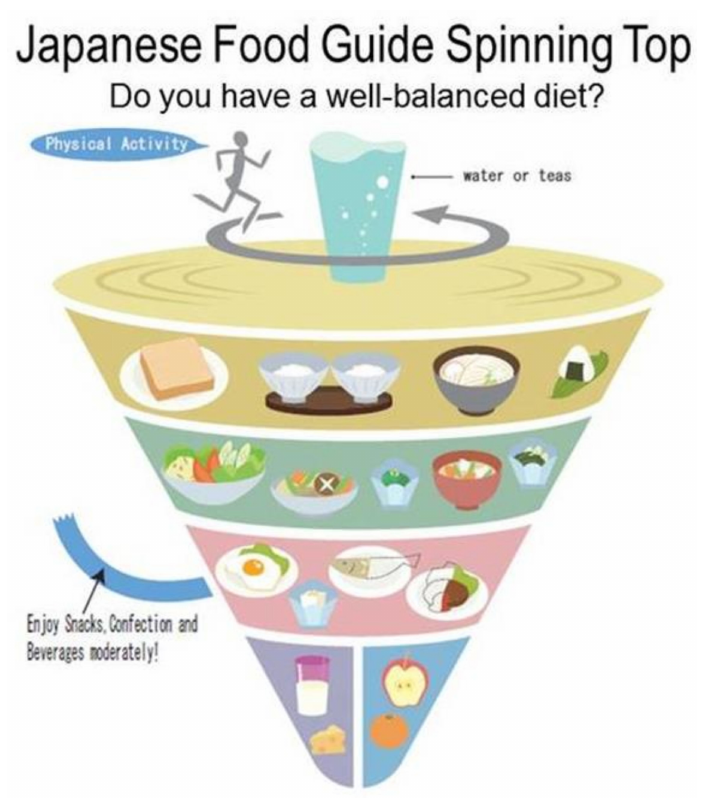
Figure 7. Japanese Food Guide Spinning Top